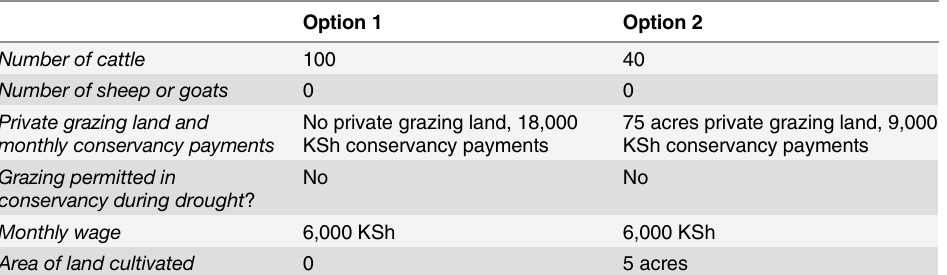
Table 1. An example of one of the choice situations presented to